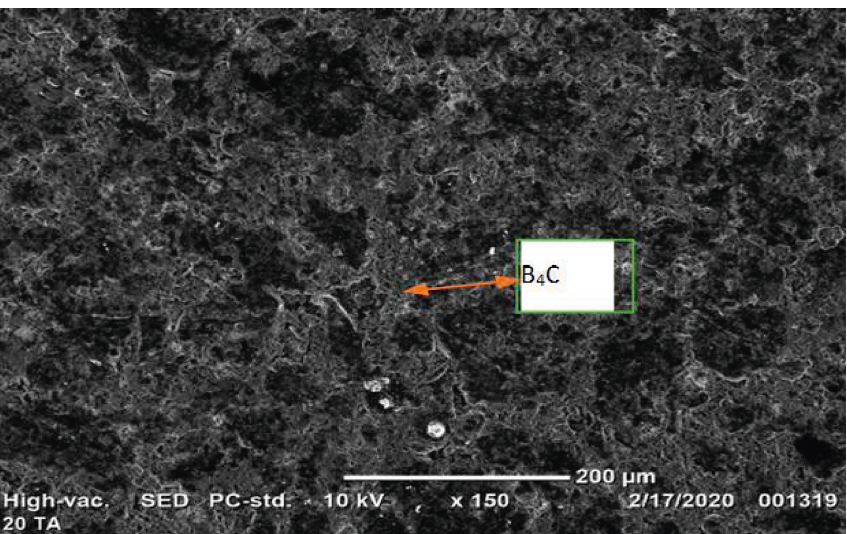
Figure 2: SEM images of fabricated aluminum (7075) B